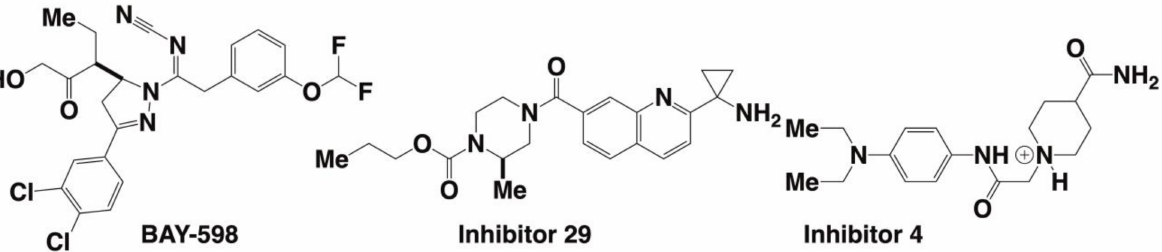
Scheme 5. Representative newly reported inhibitors for SMYD3: BAY-598 [118]; inhibitor 29 [44] and inhibitor 4